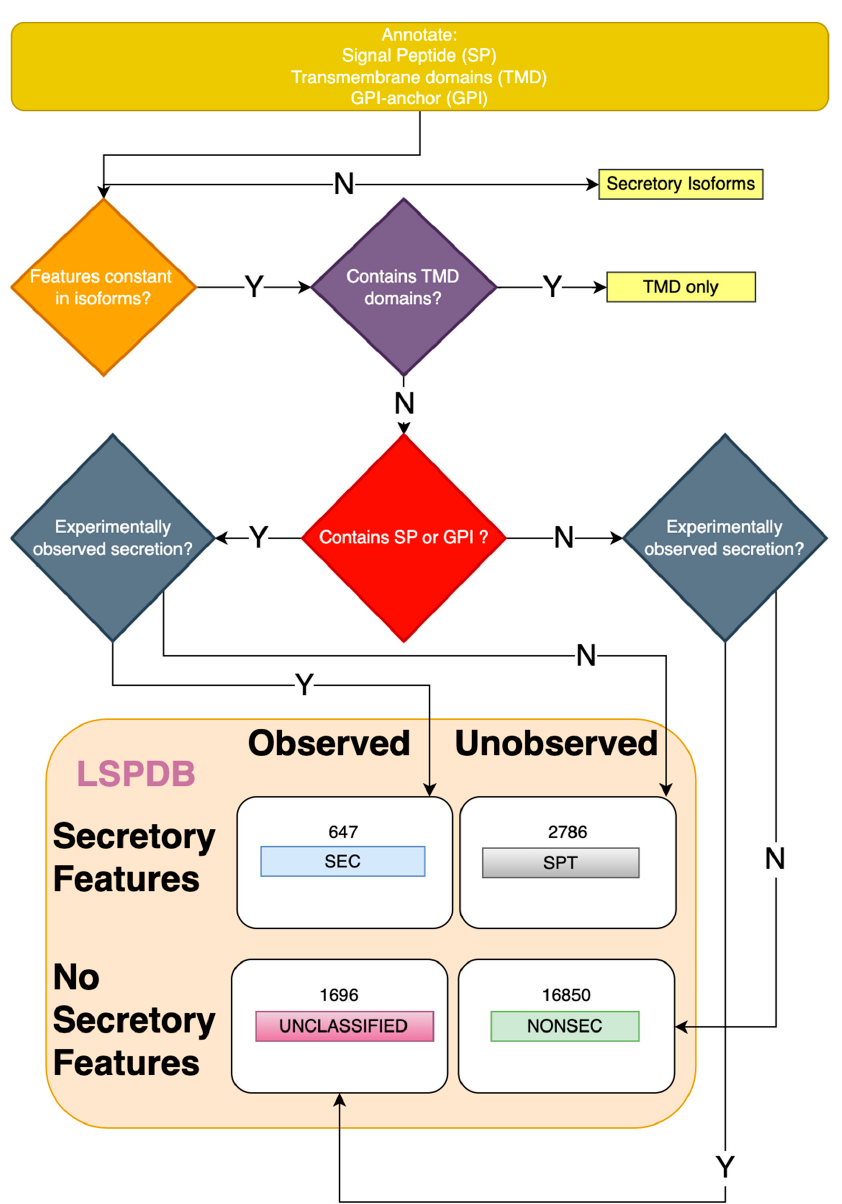
Figure 1. LSP database (LSPDB) workflow. Schematic overview of the LSPD workflow, using an entire plant proteome ( A. thaliana ) as input and annotating each protein isoform with known secretory features, including a signal peptide (SP), transmembrane domains (TMDs) and GPI anchor. Protein isoforms derived from the same gene are compared for differing secretory features to identify genes that have both secretory and non-secretory protein products, as these are not guaranteed to be able to be confidently assigned to either category. These are labelled as ‘secretory isoforms’ and not categorised further. Genes with only TMDs are also excluded from classification and are labelled ‘TM only’. The remainder are then classified based on whether they have or lack any secretory features and if they are observed or unobserved in plant cell wall/secretome papers (see Supplementary Table S1) included in the LSPDB. The combinations of classification lead to four final category labels (totals shown for Arabidopsis ): observed classically secreted proteins or SEC (647), classically secreted proteins not observed or SPT/SP_THEORY (2786), proteins observed that lack secretory features or UNCLASSIFIED (1696), and the majority of proteins that are unobserved and lack secretory proteins NONSEC